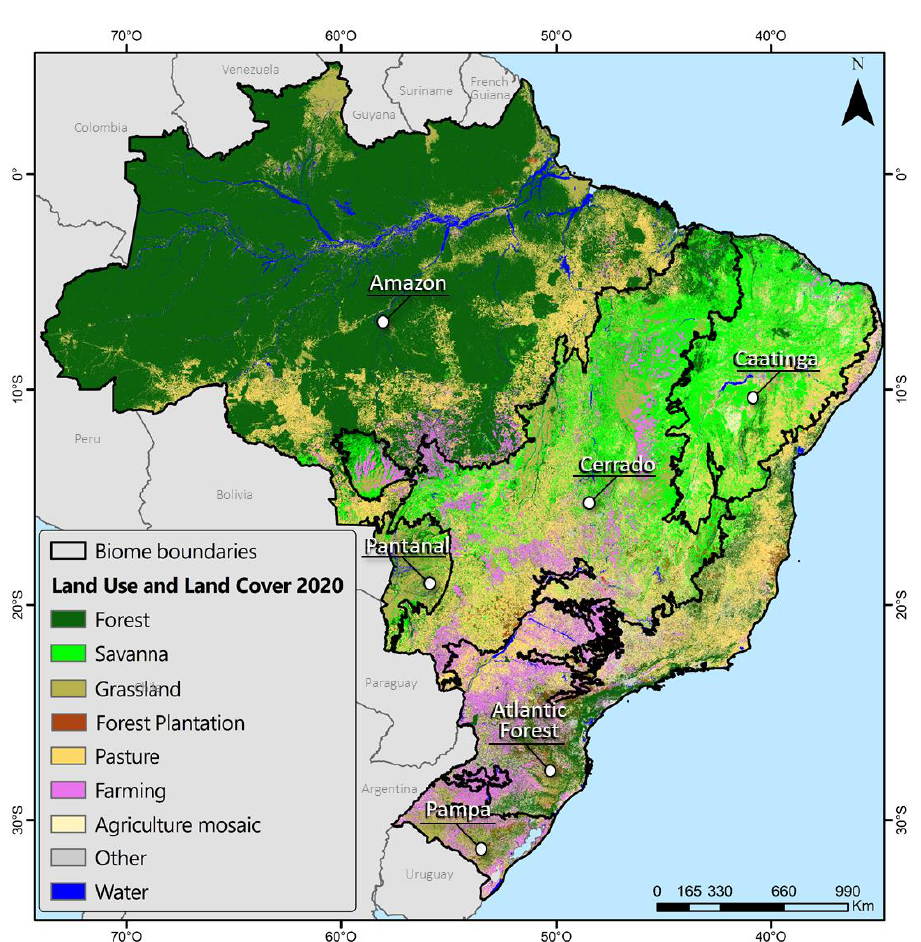
Figure 1. Study area with the six Brazilian biomes, and its corresponding land use and land cover classes according to the MapBiomas Collection 6 [50].